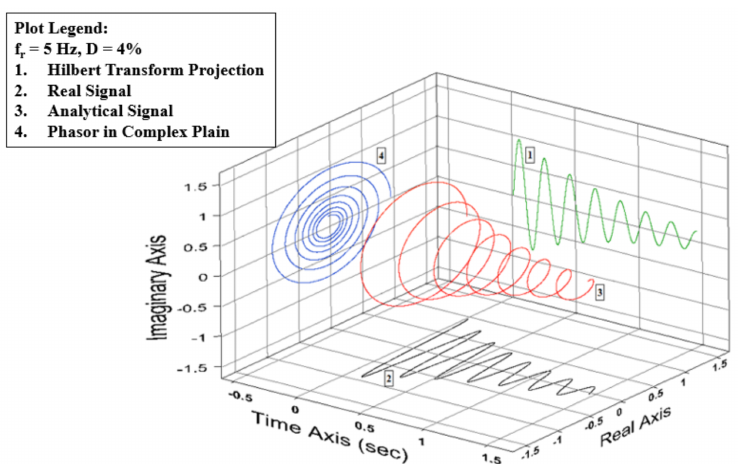
Figure 13. Analytic signal plotted in 3d, real signal projected onto the real plane, Hilbert Transform projected onto the imaginary plane, and analytic signal projected onto the complex plane [19].